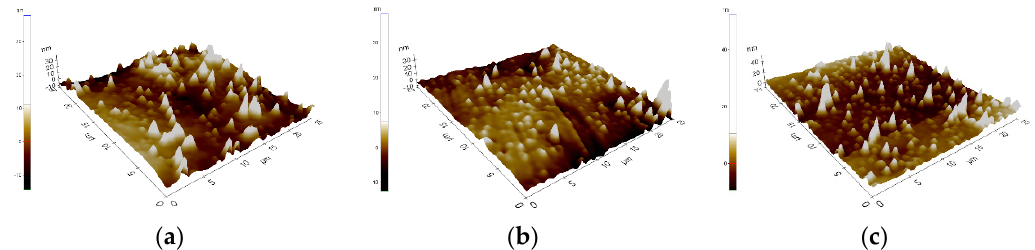
Table 4. Wettability and surface free energy results.